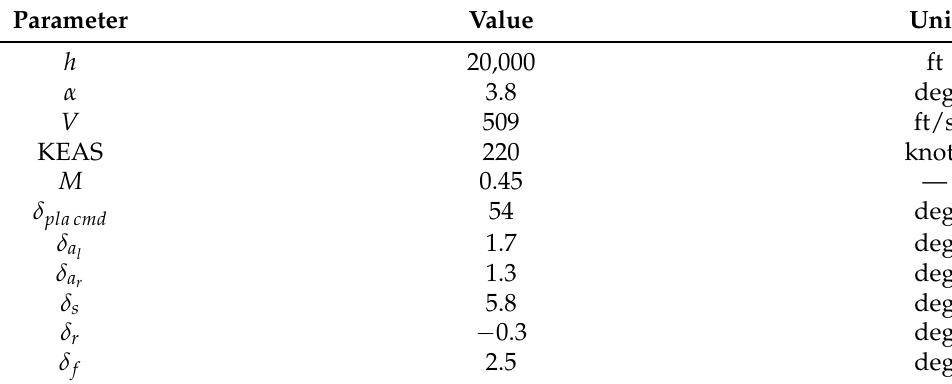
Table 3. The trimmed flight variables of the X-59 in flight condition 7220.